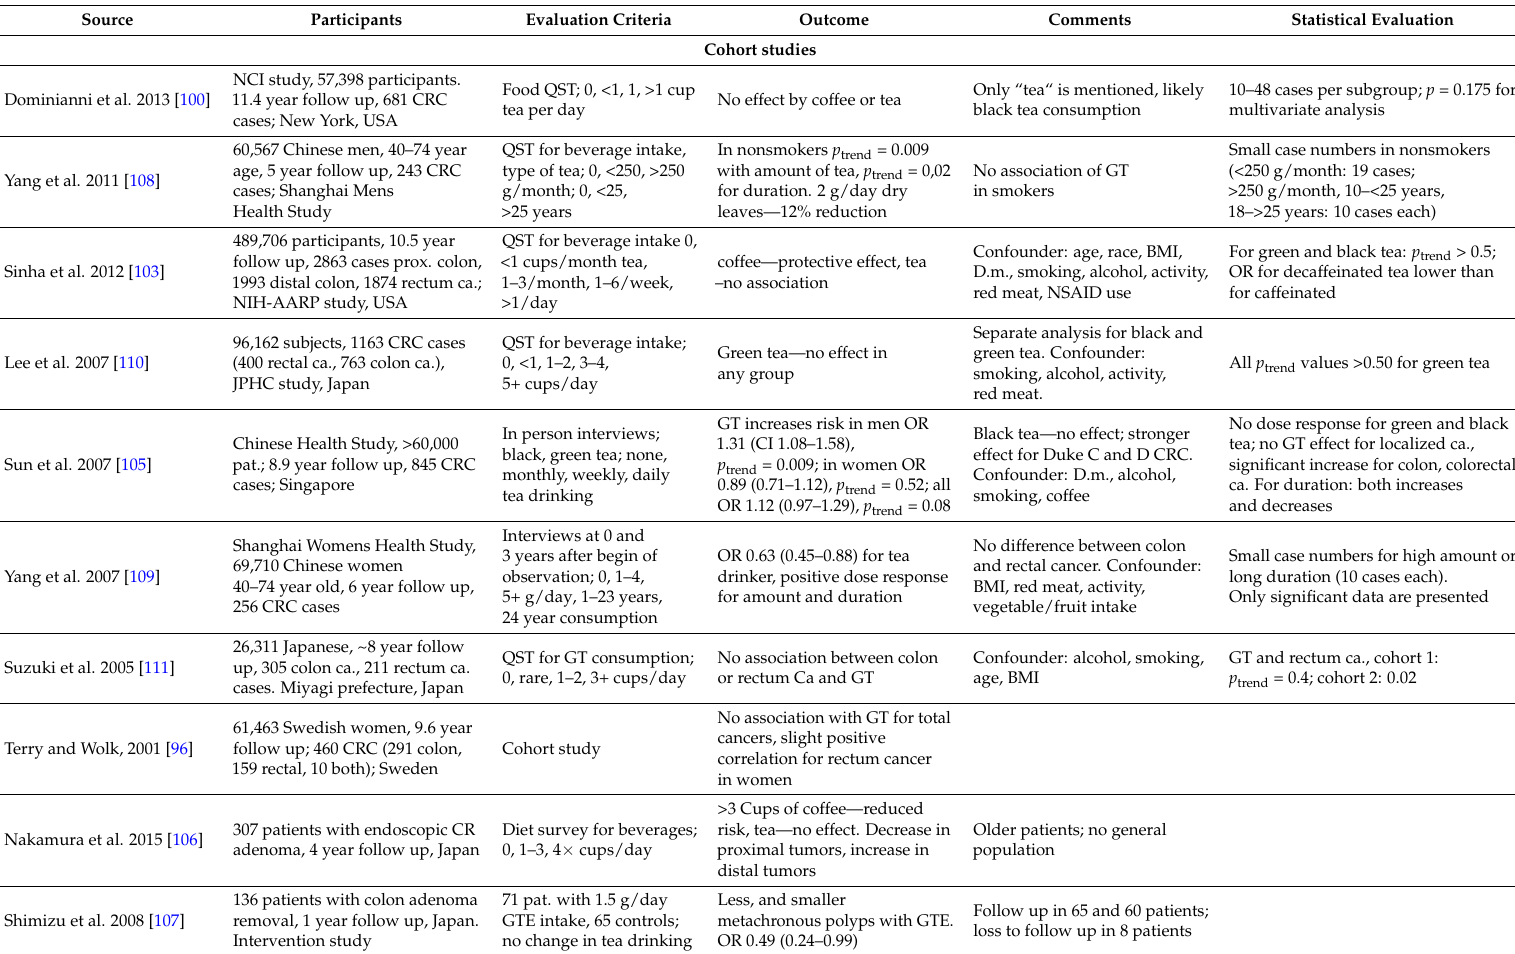
Table 2. GT and GTE extracts and colorectal